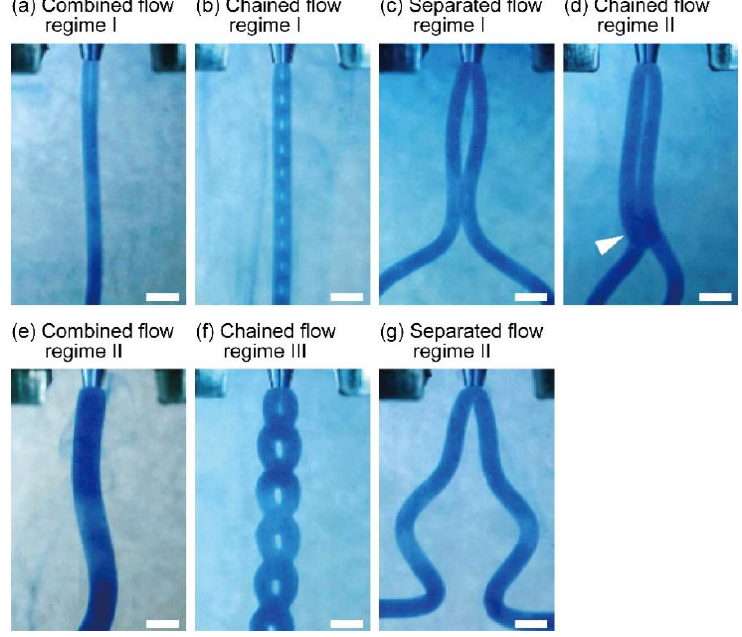
Figure 4. Flow regimes of a sodium alginate solution extruded into a calcium chloride solution at various flow rates through a theta-glass capillary: ( a ) combined flow regime I (0.01 mL/min); ( b ) chained flow regime I (0.03 mL/min); ( c ) separated flow regime I (3.0 mL/min); ( d ) chained flow regime II (4.1 mL/min). The arrowhead shows the combined part of the flow; ( e ) combined flow regime II (7.0 mL/min); ( f ) chained flow regime III (9.0 mL/min); ( g ) separated flow regime II (11 mL/min). Scale bars are 1 mm.